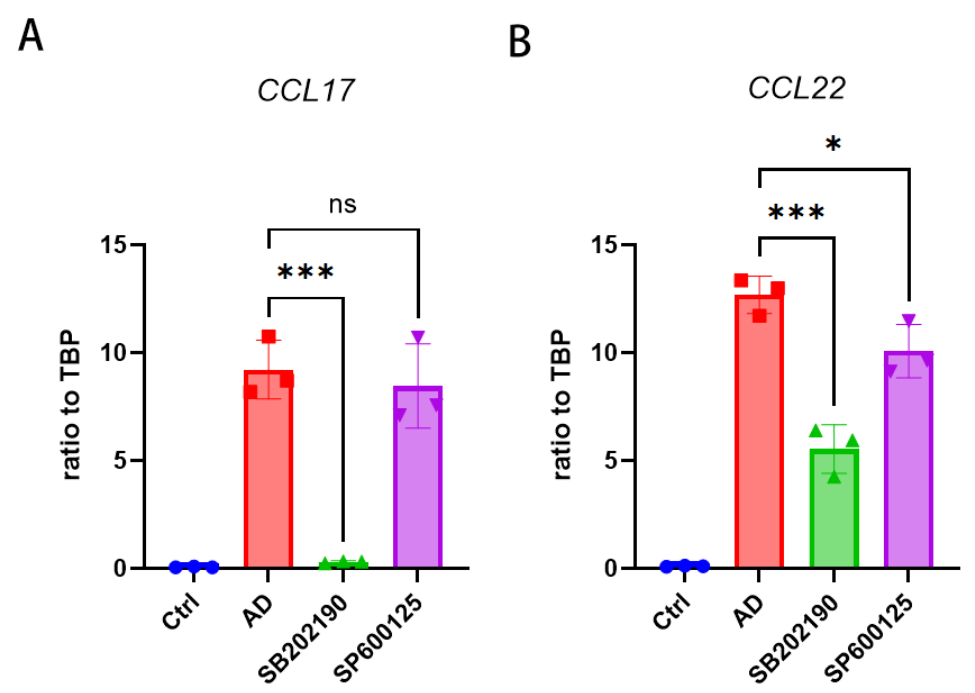
Figure 4. CCL17 and CCL22 expression is promoted by p38 MAPK and JNK in response to TNF- α /IFN- γ . Pre-treatment with SB202190 (5 µ M), SP600125 (10 µ M) for 30 min. A 20 h application of TNF- α and IFN- γ (10 ng/mL) followed. ( A ) CCL17 mRNA levels. ( B ) CCL22 mRNA levels. A minimum of three experiments were used to calculate the mean ± SEM, *** p < 0.001, * p < 0.05, ns stands for not significant.